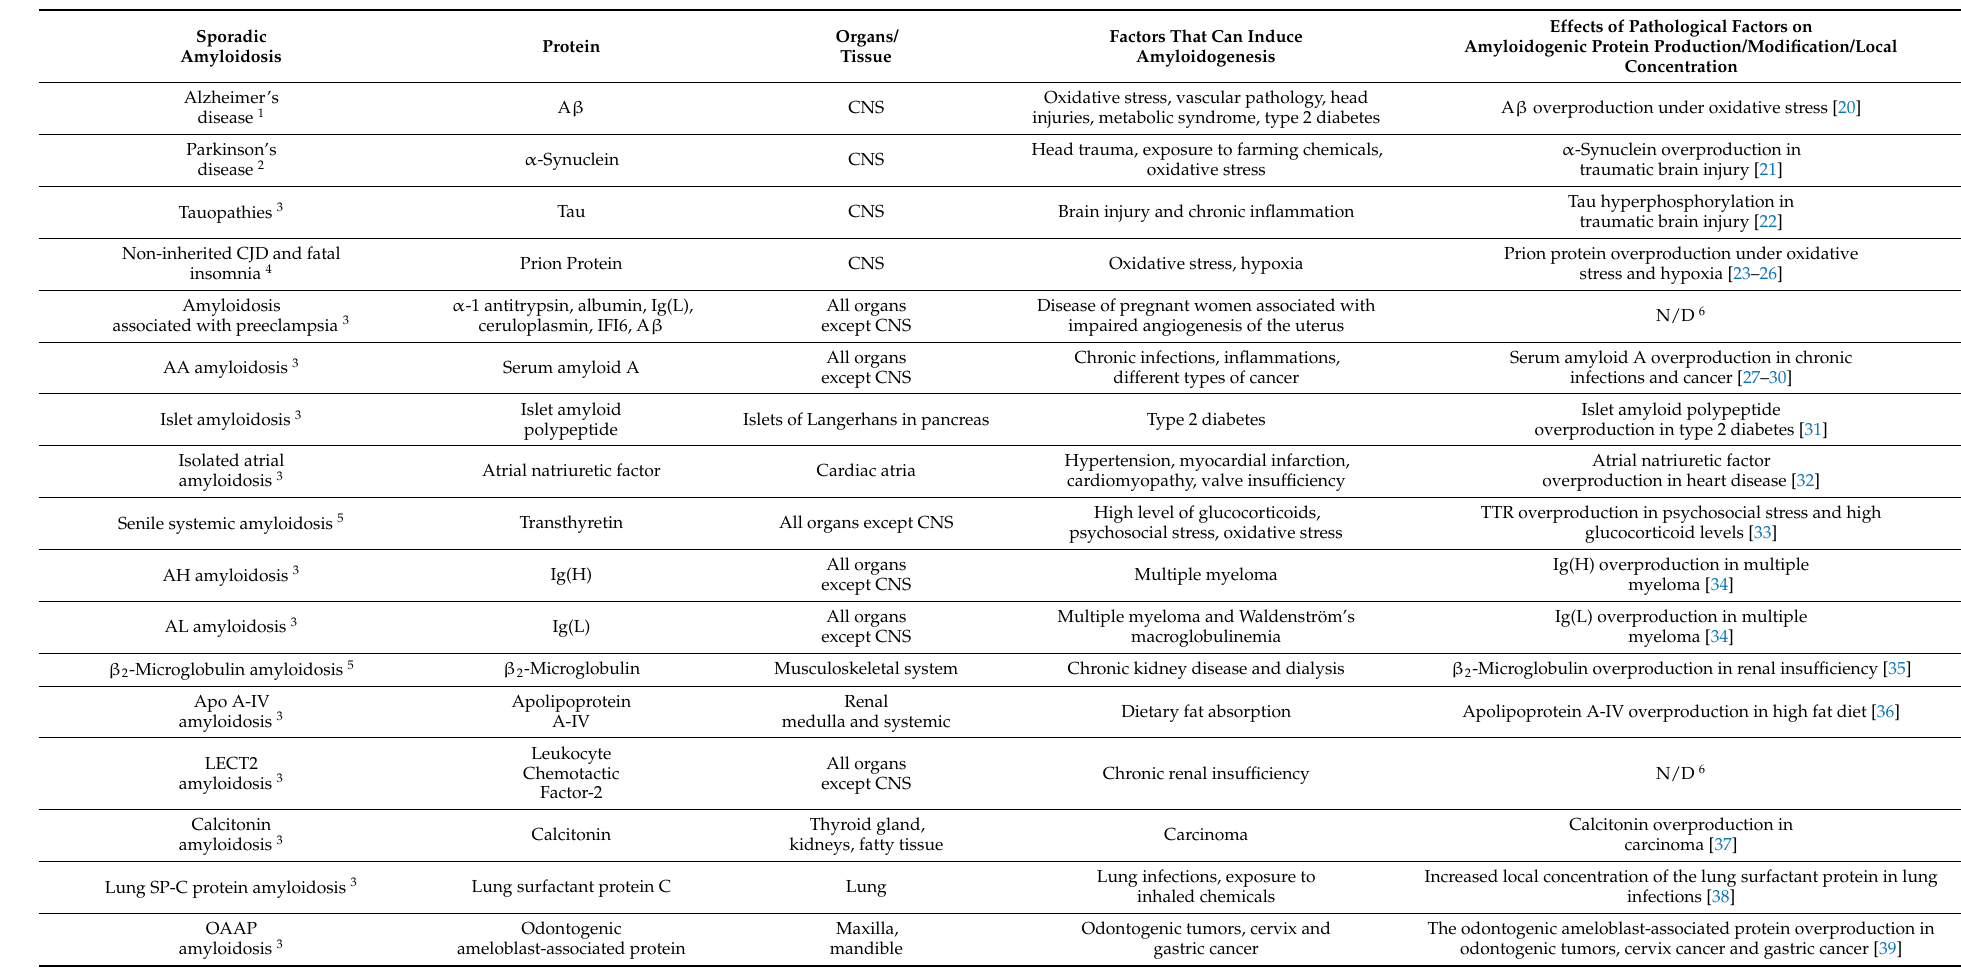
Table 1. Risk factors for sporadic